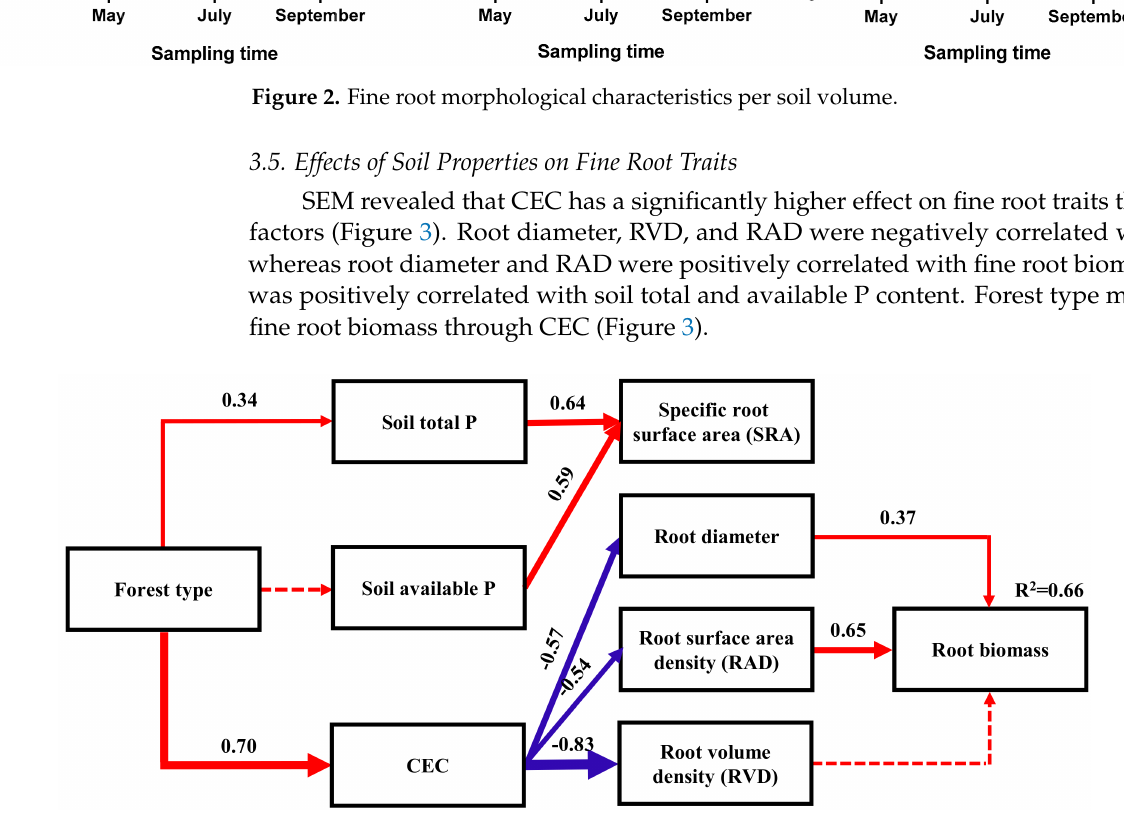
Figure 3. Structural equation model relating forest type effect on fine root traits ( χ 2 = 72.16; df = 11; p = 0.475; comparative fit index (CFI) = 1.000; root mean square error of approximation (RMSEA) = 0.000). Rectangles represent observed variables; arrow thickness represents the magnitude of the path coefficient. Solid line arrows represent significant paths ( p < 0.05), dashed lines represent non-significant paths ( p > 0.05). Red lines represent the positive paths, and blue lines represent the negative